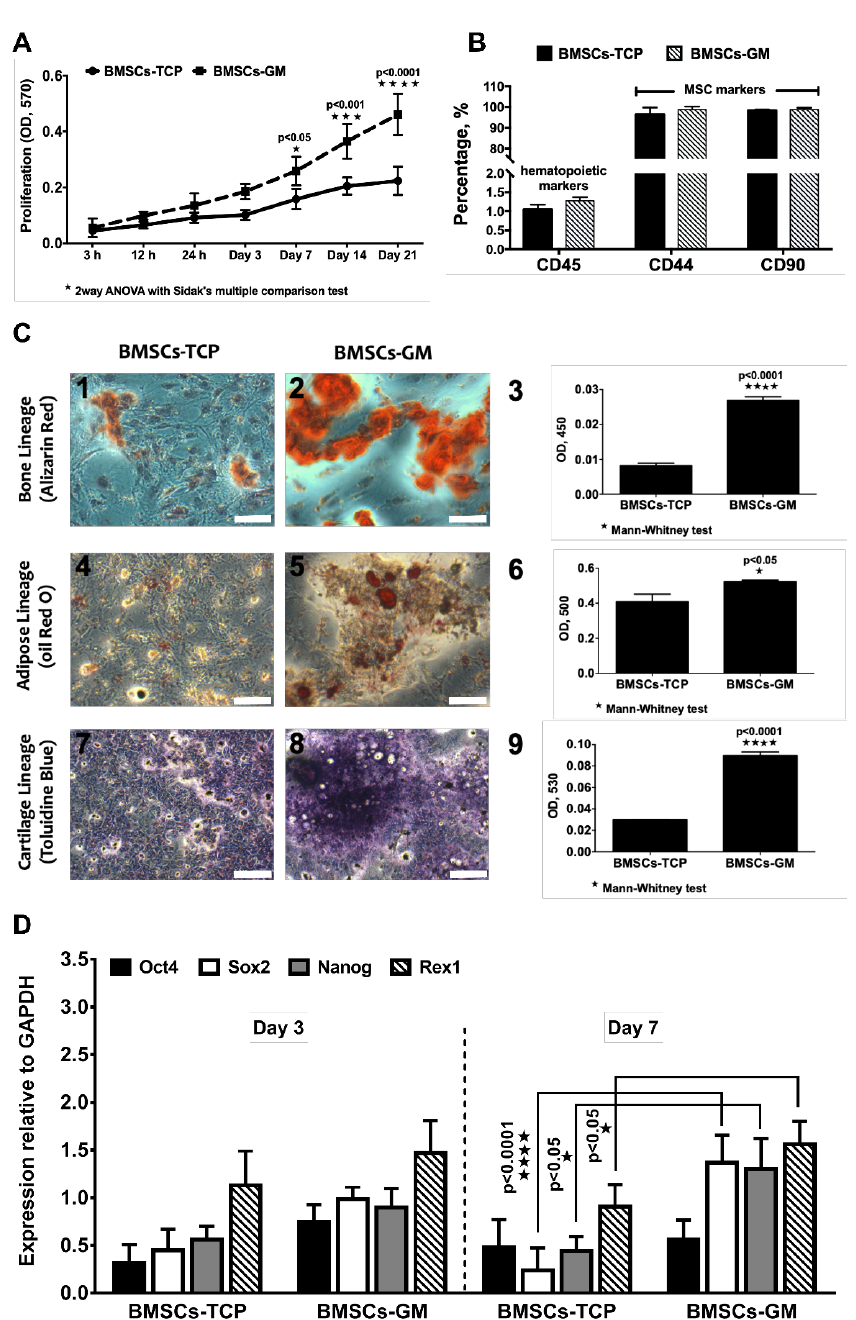
Figure 3. Cell growth, characterization and differentiation of BMSCs on a tissue culture plate ( TCP) (2D) and GM (3D). ( A ) The proliferation of BMSCs-TCP and BMSCs-GM studied using Presto Blue assay. ( B ) Immunophenotype of BMSCs-TCP and BMSCs-GM via flow cytometry analysis ( C ) Optical microscope images of Alizarin Red for osteogenic differentiation, Oil Red O staining for adipogenic differentiation and Toluidine Blue staining for chondrogenic differentiation. ( D ) Stemness marker genes Oct4, Sox2, Nanog, and Rex1 of BMSCs-TCP and BMSCs-GM after day 3 and day 7. The sample size ( n ) for each experiment was six ( n = 6). (BMSCs-TCP/day 3; BMSCs-GM/day 3; BMSCs-TCP/day 7; BMSCs-GM/day 7). (Figure 3C: 100× Magnification; scale bar: 100µm).